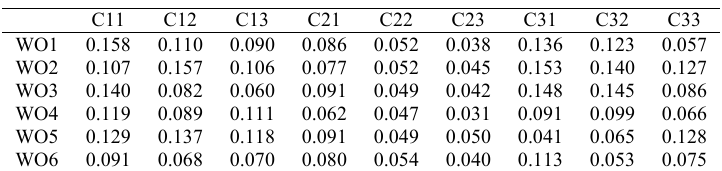
Table 8: The weighted normalized decision matrix